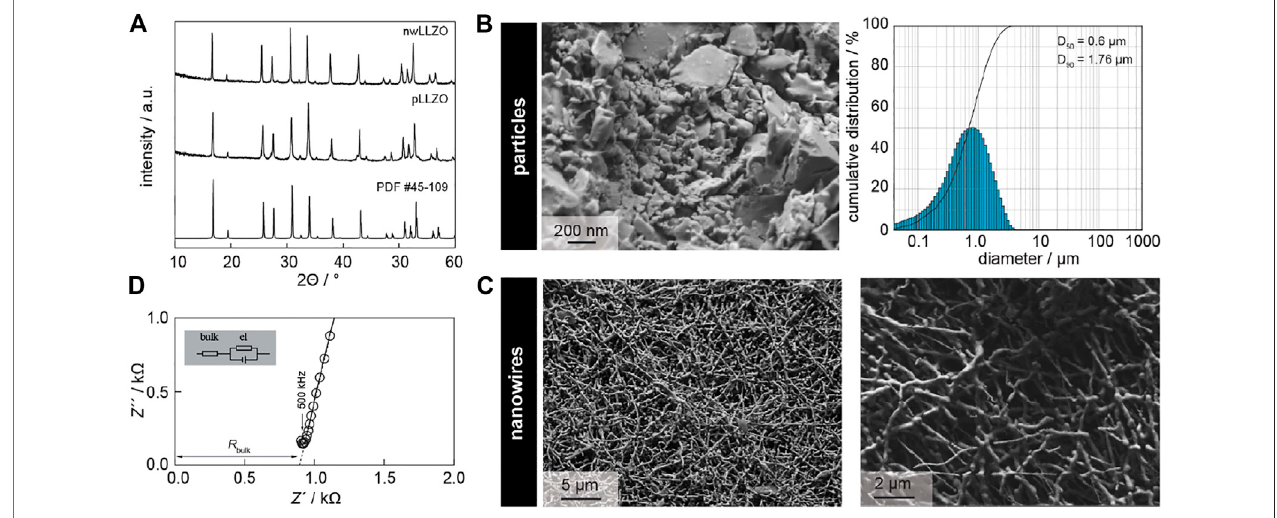
FIGURE 2 | (A) X-ray diffraction patterns of pLLZO and nwLLZO along with the JCPDS of cubic garnet. (B) SEM image and particle size distribution of pLLZO. (C) SEM images of the as-prepared nwLLZO (left) and calcined nwLLZO (right). (D) Nyquist plot of pLLZO and inset in (D) is the equivalent circuit diagram used for